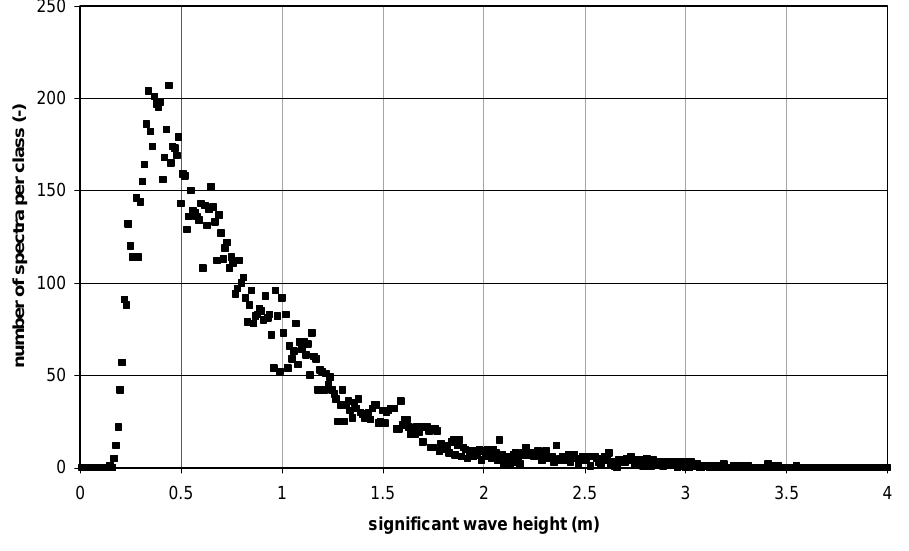
Figure 6. Spectra Bol van Heist 1998: distribution of wave height classes (0.01 m interval). The spectra are grouped in discrete Hs -classes ] Hs j – d Hs ; Hs j ], with Hs j = j d Hs . Taking account of the large number of data, wave height classes are defined with d Hs = 0.01 m intervals. Figure 6 shows the number of spectra in each interval for the measurements at Bol van Heist in 1998. The number of spectra in wave height class j is denoted n jcond